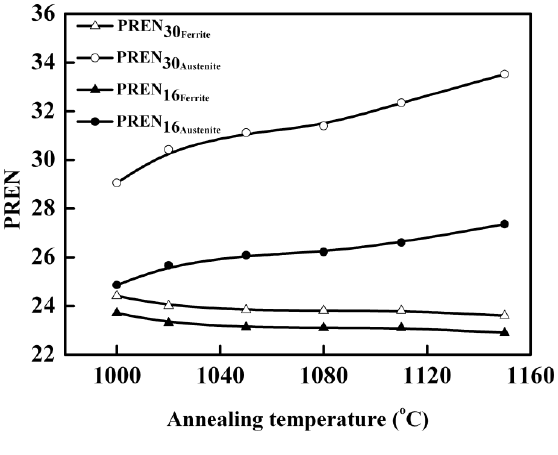
Figure 10. PREN for each phase of specimens with different annealing temperatures for 30